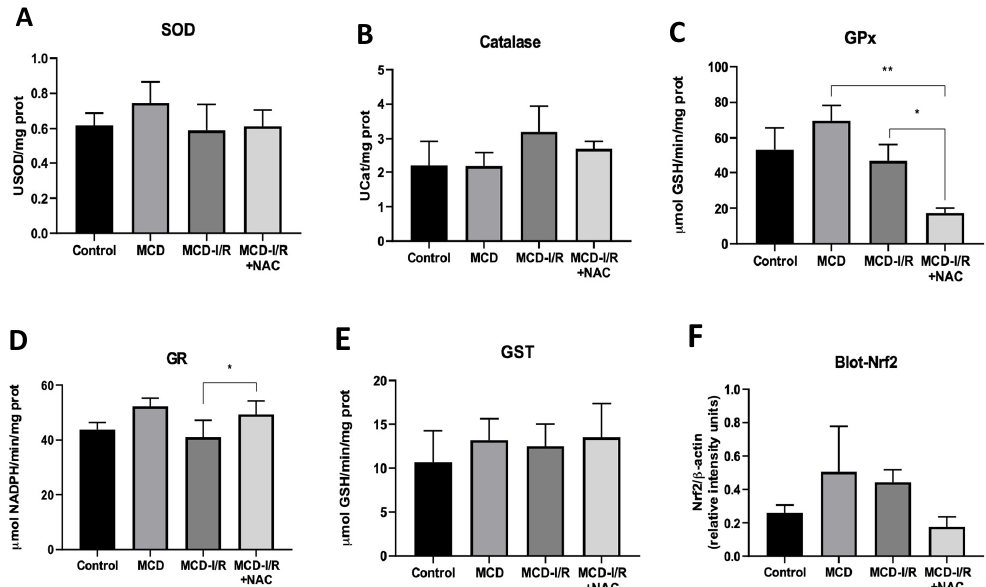
Figure 3. Activities of antioxidant enzymes and transcription factor Nrf2 in the liver of normal mice and of animals submitted to I/R in the MCD diet treated or not with N -acetylcysteine. This figure shows activity of ( A ) Superoxide dismutase, ( B ) catalase, ( C ) glutathione peroxidase, ( D ) glutathione reductase, and ( E ) glutathione S-transferase (* p < 0.05 vs. MCD-I/R; ** p < 0.01 vs. MCD; N = 5–6; Tukey one-way ANOVA), and ( F ) analysis of the densitometry of the Western blot evaluation of transcription factor Nrf2 ( p < 0.08 vs. MCD-I/R; N = 4; one-way ANOVA).